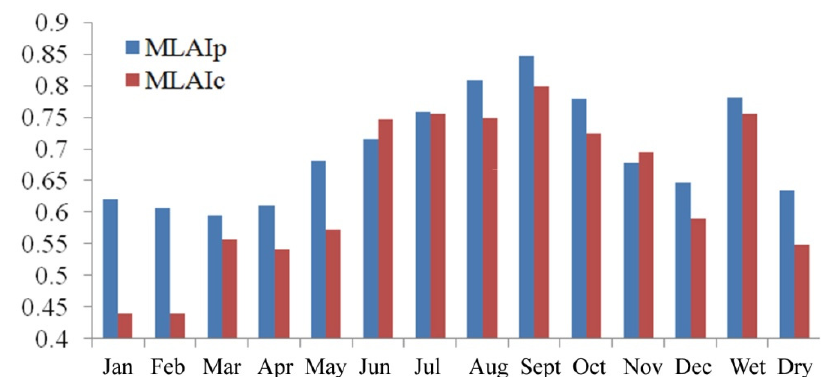
Figure 9. ( a ) Linear slope of annual maximum LAI from GIMMS; ( b ) Linear slope of annual maximum LAI from the Biome-BGC model (1982–2006) (Significant: passed significance level of 0.05).